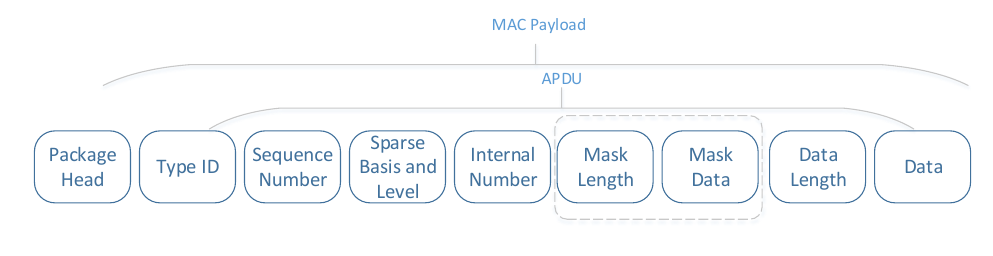
Figure 15. Packet structure.